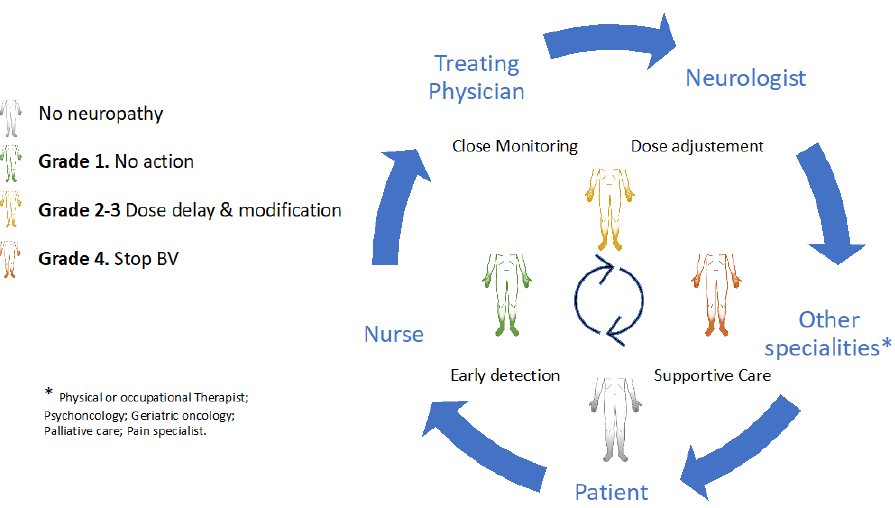
Figure 2. A multidisciplinary approach in brentuximab-induced peripheral neurotoxicity